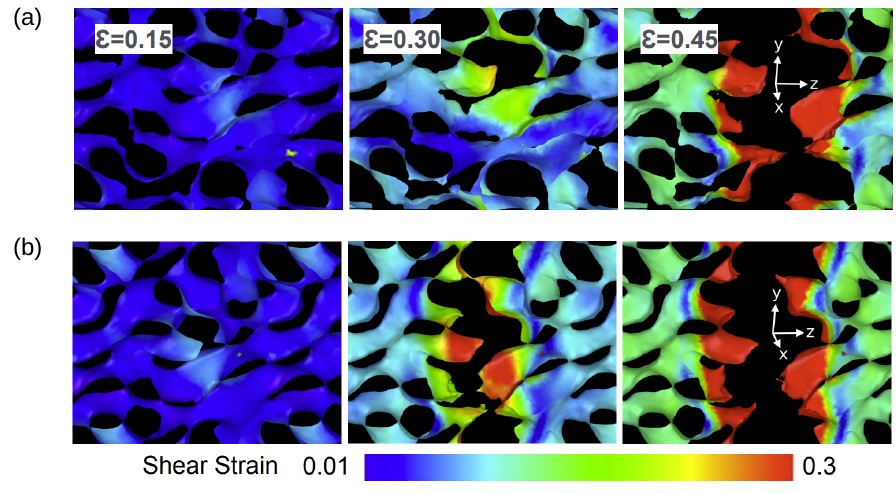
Figure 7. Shear strains for samples with ( a ) sp 3 = 22.3% and ( b ) sp 3 = 49.1% Snapshots correspond to strains of 0.15, 0.30, and 0.45. Color coding represents the atomic shear strain.